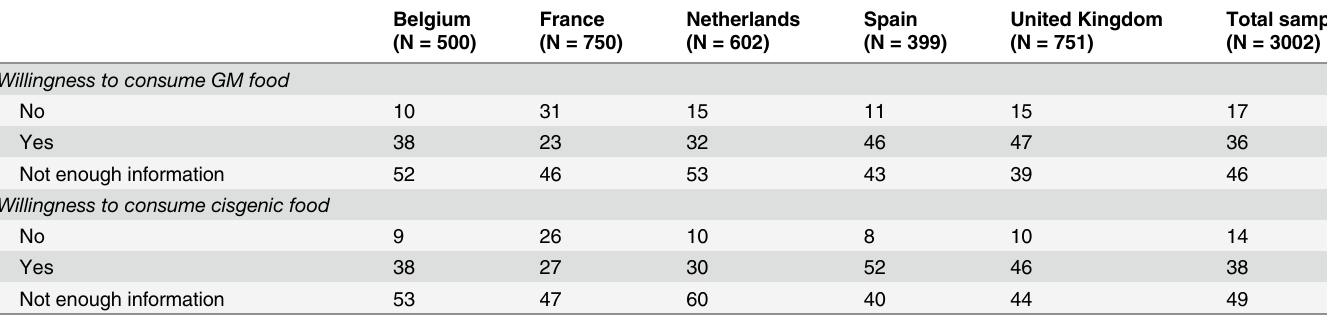
Table 5. Willingness to consume GM and cisgenic food by country